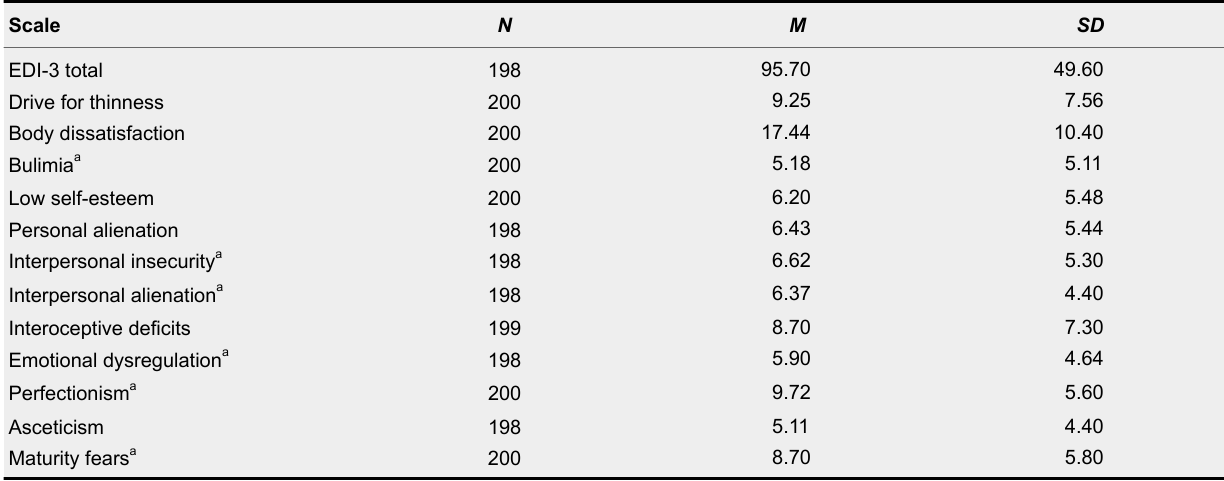
Mean Scores on the Eating Disorder Inventory-3